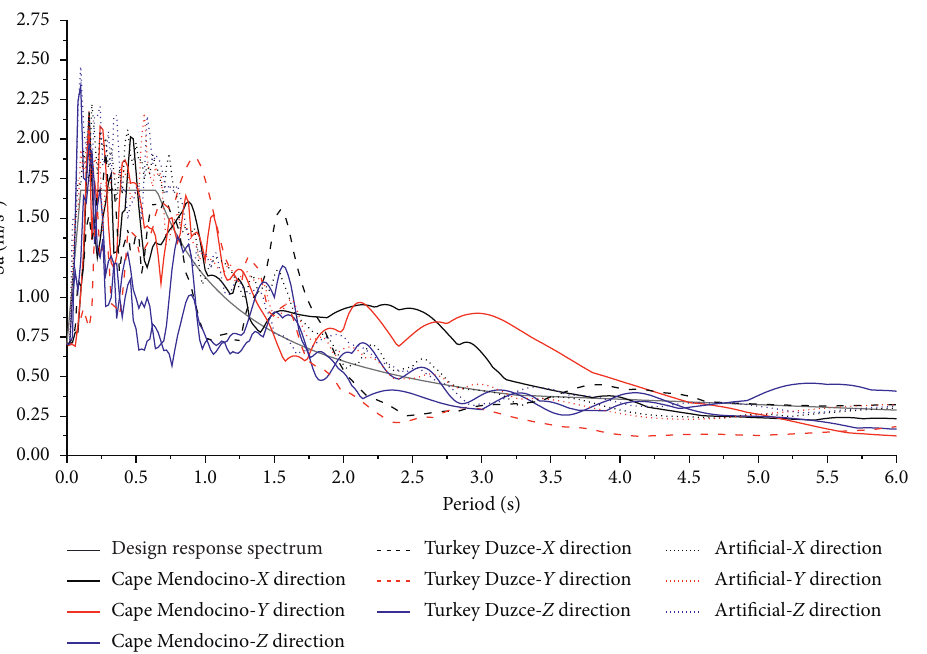
Figure 9: Response spectrum curves of seismic records selected and design response spectrum